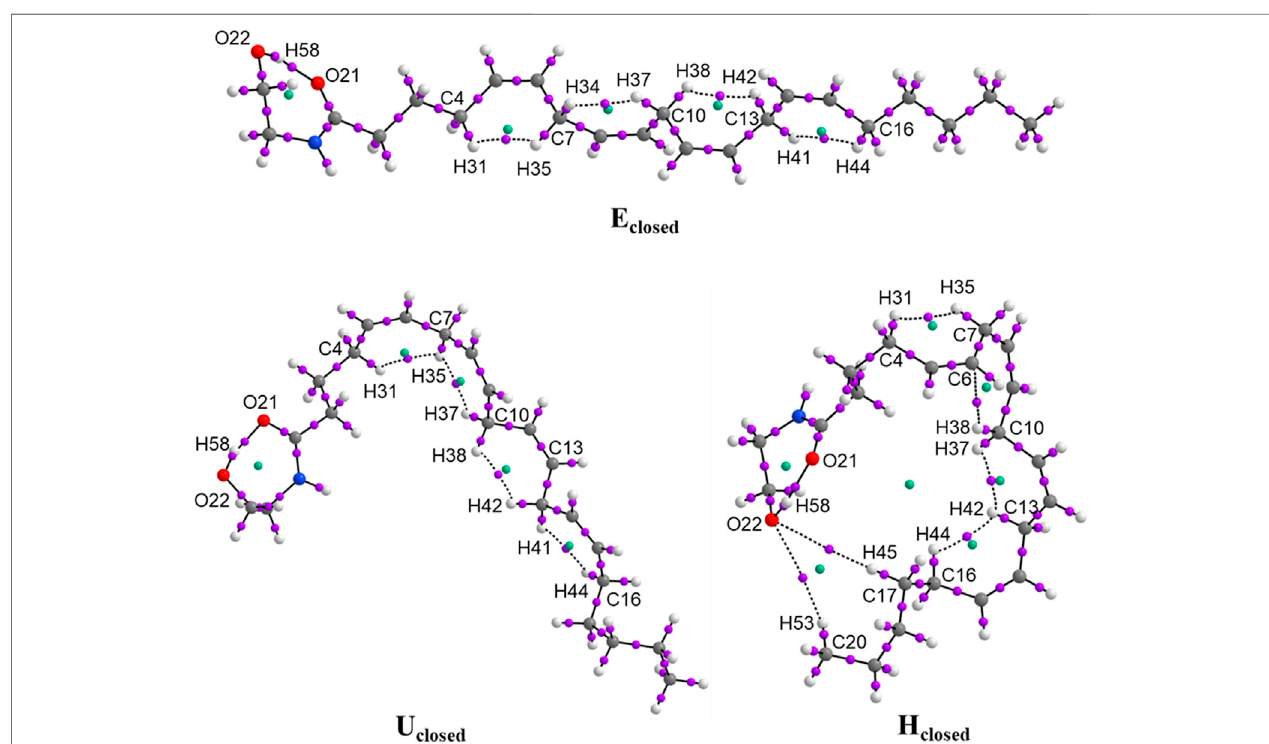
FIGURE 2 | Molecular graphs of the conformers of anandamide: E closed , U closed , and H closed , obtained at the BP86/cc-pVTZ level of theory in chloroform.